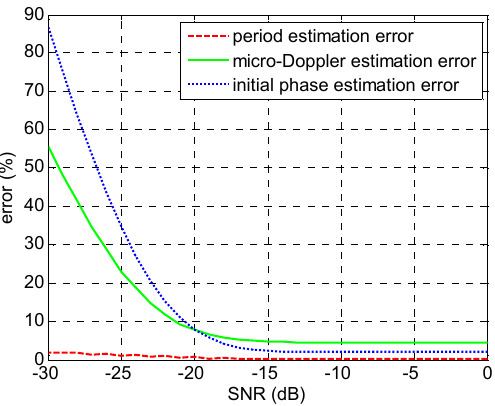
Figure 9. Relationships between signal ‐ to ‐ noise ratio (SNR) and the parameter estimation errors.